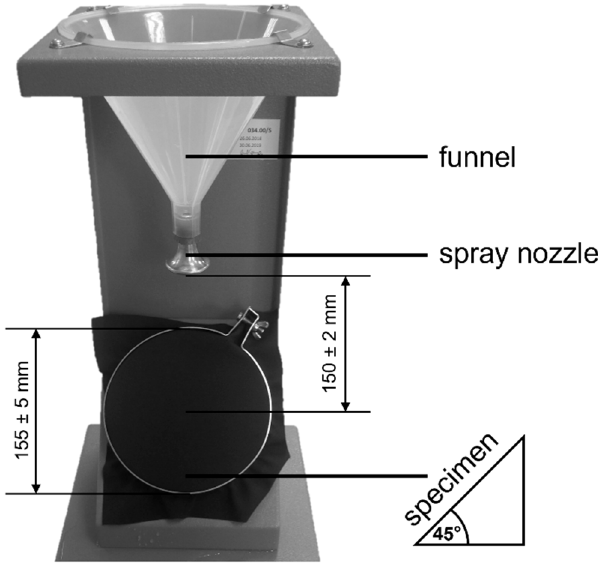
Figure 2. Spray tester used in the study.